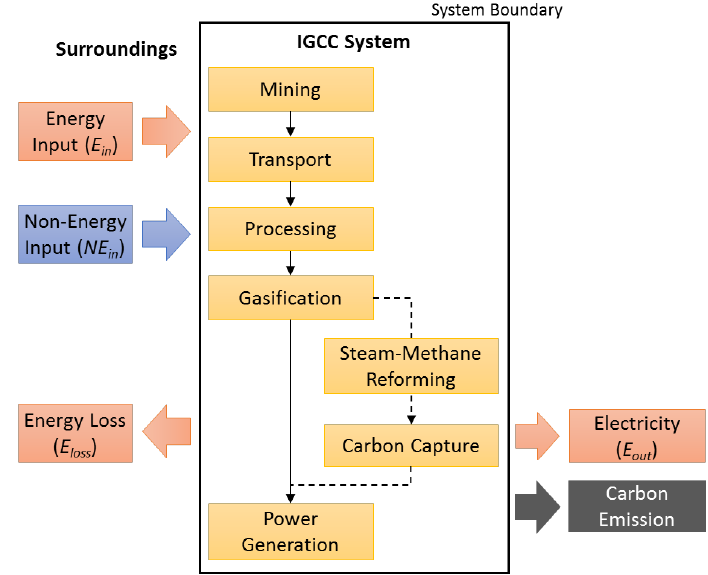
Figure 4. Life cycle system of the integrated gasification combined cycle (IGCC) power generation from with pre-combustion carbon capture.